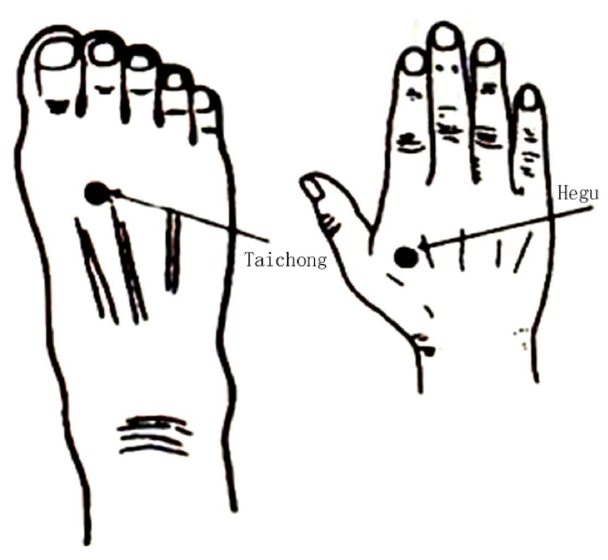
Figure 1. Location of acupoints used in the experiment. The left acupoint represent Taichong, which is located in the dorsal foot, the first and second metatarsal cavity before integration. The right acupoint represent Hegu, which is located in the dorsal hand, between the first and second metacarpal and the midpoint of the second metacarpal radial